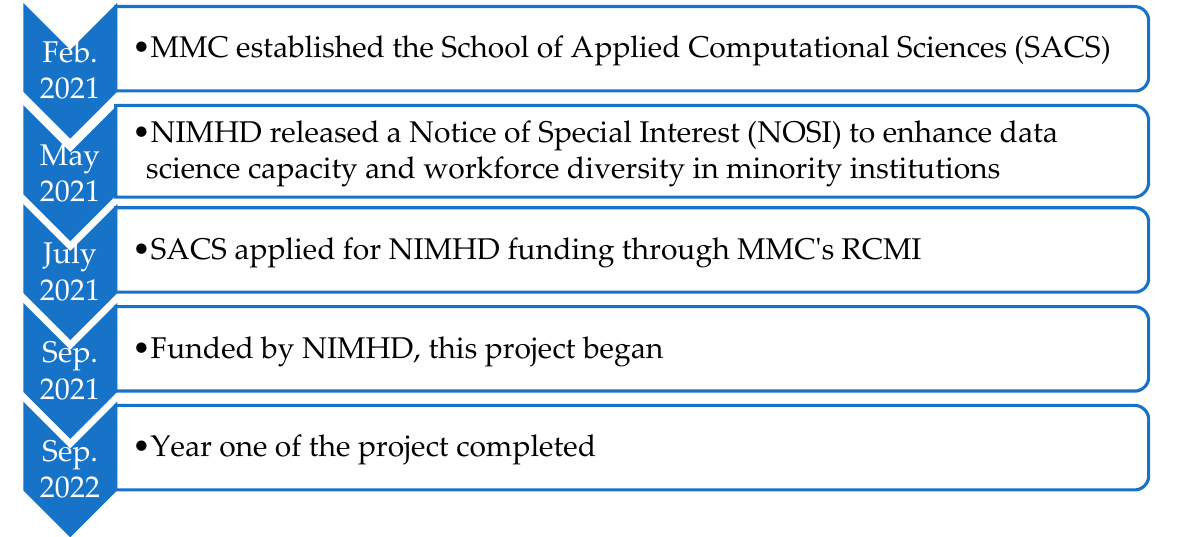
Figure 1. Roadmap of this NIMHD-funded project.